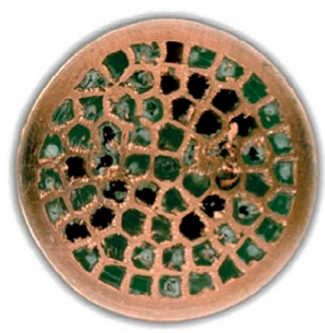
Figure 18. UniPore structure with 46.7% porosity filled with phase change material (PCM). Reproduced from [1], with permission from Elsevier,